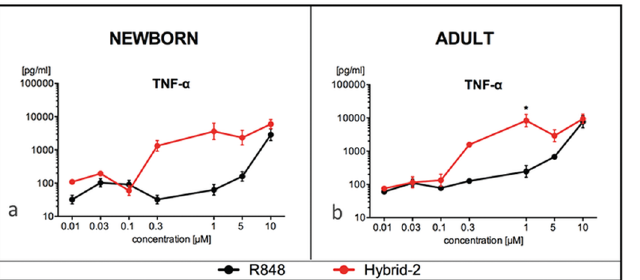
Supernatants collected for TNF ELISA. Compound concentrations are shown in μ M. Data are shown as mean ± SEM of n = 5. For between-agonist analyses, t test was applied to compare Hybrid-2 to R848. Statistical significance is denoted as follows: * p < 0.05 as a black star.